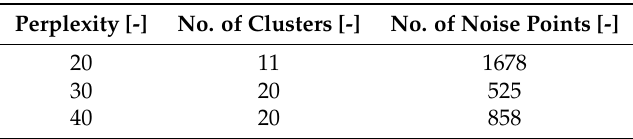
Figure 4. Reduced space of topomaps after using t-SNE with a perplexity of 40 ( top left ). Reduced space of topomaps after using t-SNE with a perplexity of 30 ( top right ). Reduced space of topomaps after using t-SNE with a perplexity of 20 ( bottom ). For all settings, the perplexity was used to reduce IC space. Table 1. The number of noise points and number of clusters resulting from DBSCAN for different values of perplexity in the t -SNE method used on IC